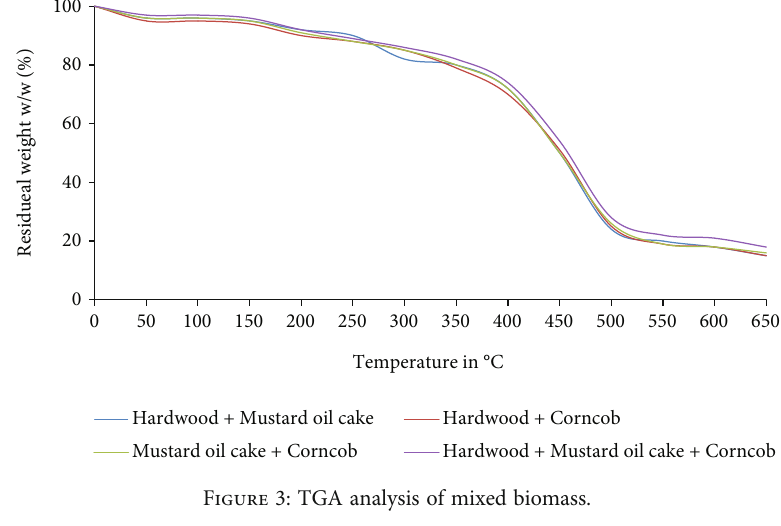
Figure 3: TGA analysis of mixed biomass.